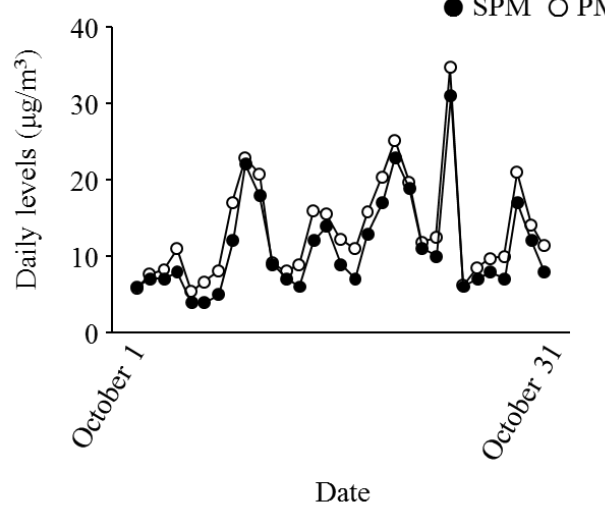
Figure 1. Daily average levels of SPM (closed circles) and PM 2.5 (open circles). SPM = suspended particulate matter, PM 2.5 = particulate matter smaller than 2.5 μm aerodynamic diameters.